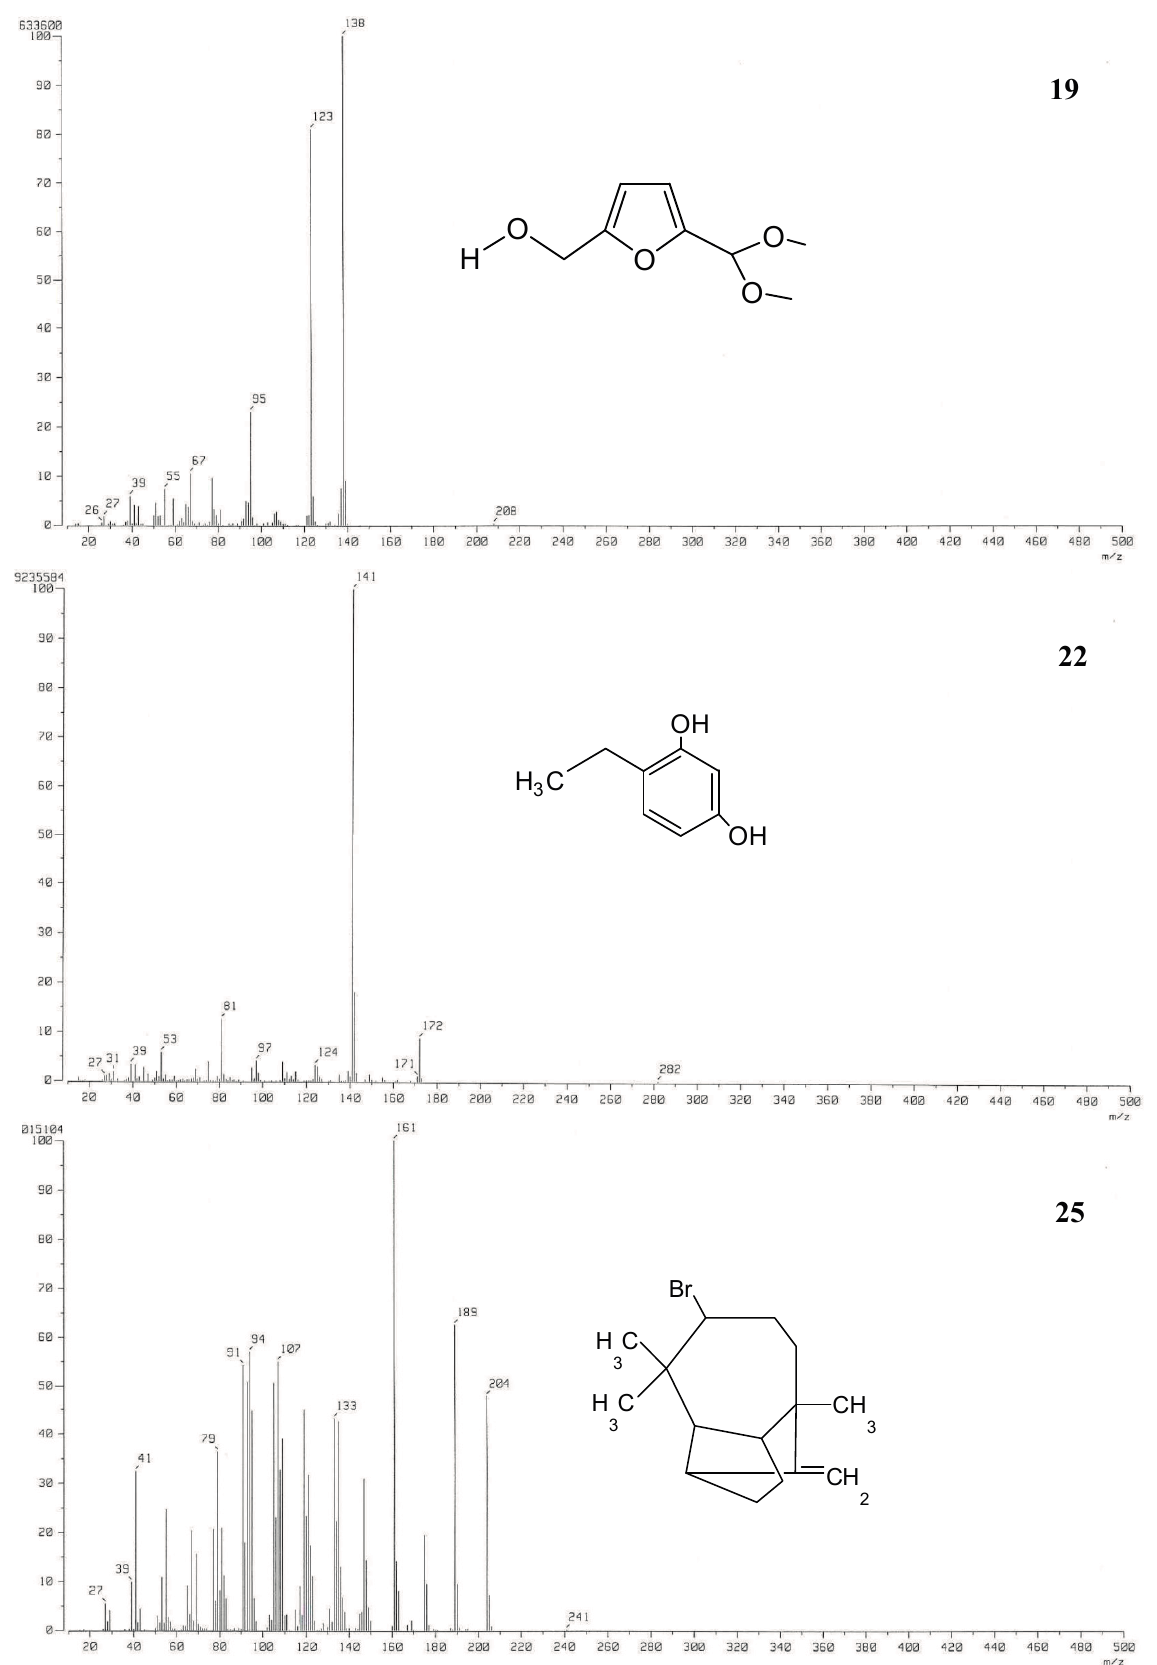
Figure 2. Chemical structure and spectra of some medicinally important compounds present in Japanese red pine sawdust bio-oil